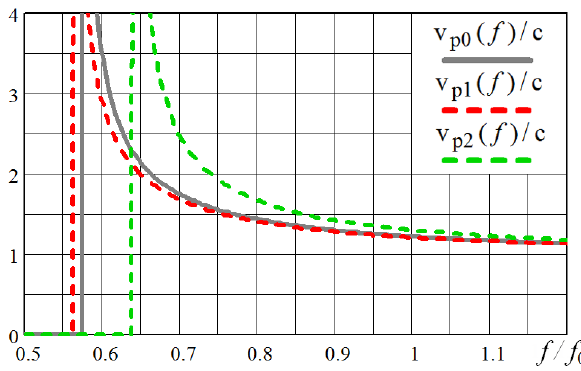
FIGURE 4. Phase velocities of TE eigenmodes of a square waveguide with and without diagonally located square corner conducting irises